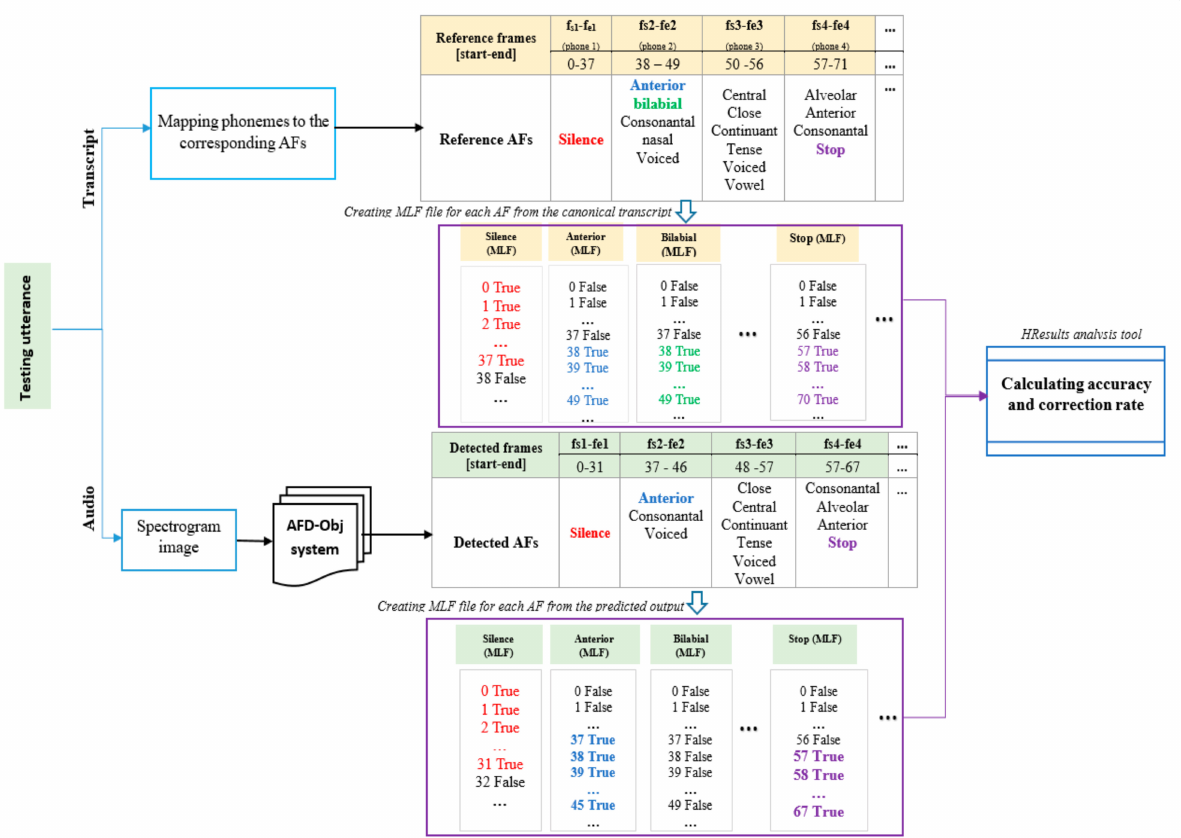
Figure 8. Testing phase of the AFD-Obj system: calculate the frame level accuracy of the detected outputs.